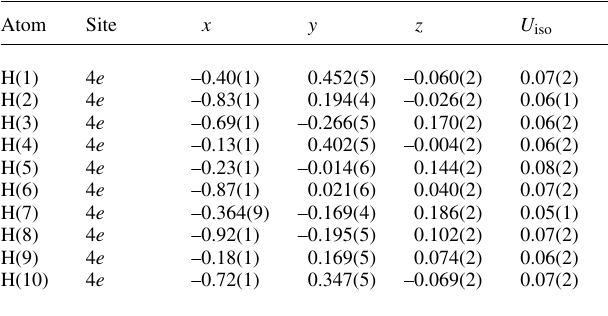
Table 2. Atomic coordinates and displacement parameters (in Å 2 )